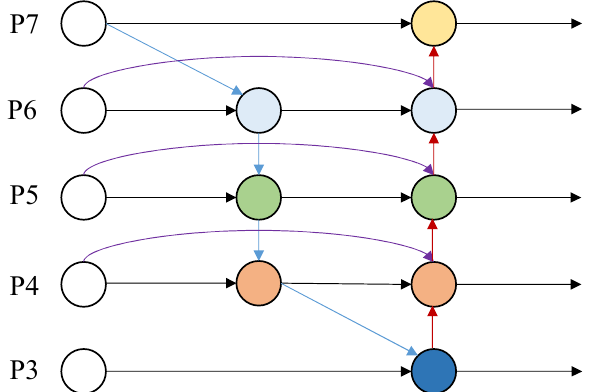
Figure 2. BiFPN [10] Network